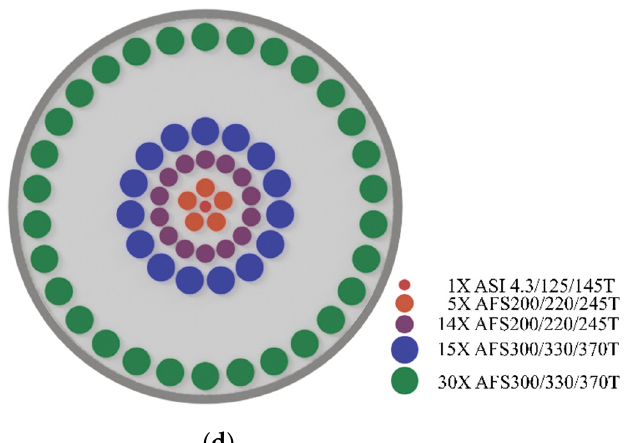
Figure 1. ( a ) Cross-sectional photograph of the fibre bundle (showing only the central emitting fibre, as well as the innermost and outermost rings). All configurations share the same general geometrical scheme, but the exact geometry of the bundle and the physical and optical characteristics of the fibres vary from configuration to configuration. ( b ) Illustration of the working principle of the optical sensor: The reflected light is collected by two independent rings of receiving fibres. ( c ) Detailed description of the fibre bundle in the fifth configuration. ( d ) Cross-section of the fibre bundle in the fifth configuration (OS 3).